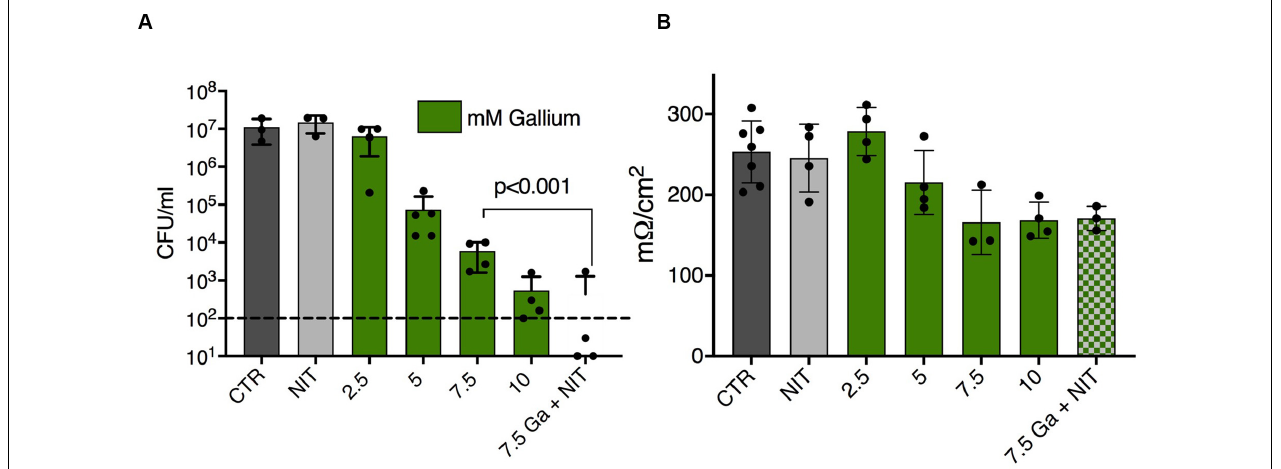
FIGURE 3 | Ga 3 + and nitrite have synergistic antibiofilm activity. (A) Biofilm growth prevention assays done with PAO1 grown in PVC microtiter disks and stained with crystal violet. Asterisks indicated well scored with no growth. Four replicates done. (B) Representative results of a biofilm prevention assay in which final optical density of the crystal violet was measured spectrophotometrically. Highlighted cells show growth as defined as < 20% reduction in OD compared to the control well. Three replicates were done.